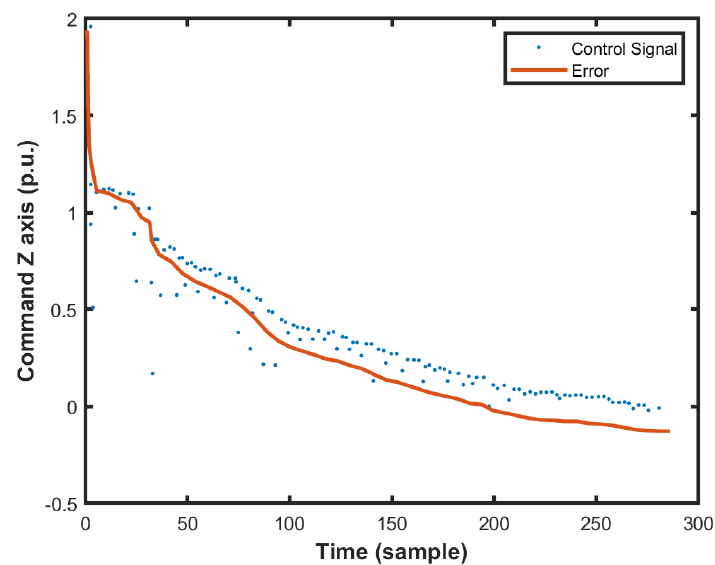
Figure 18. Control signal and error during the experimental